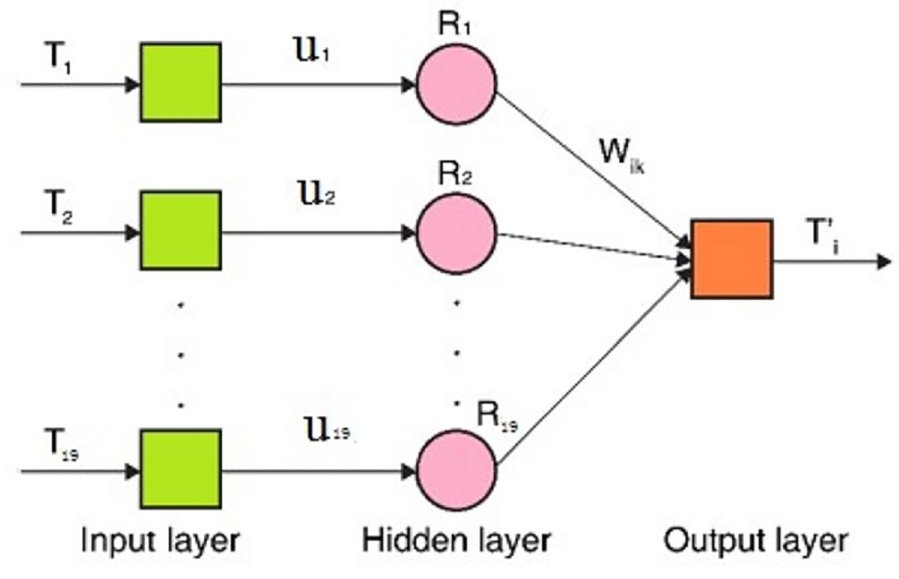
Fig 2. Error compensation